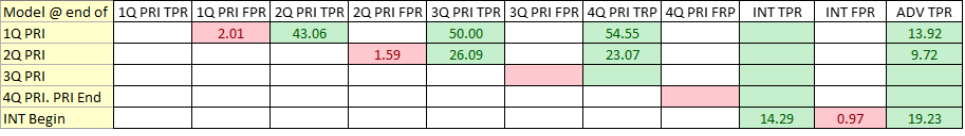
Figure 18. True and false positive rate of selected ML models for the most cost